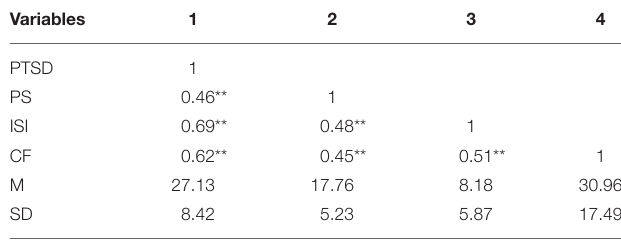
TABLE 2 | Descriptive statistics and correlation among variables.